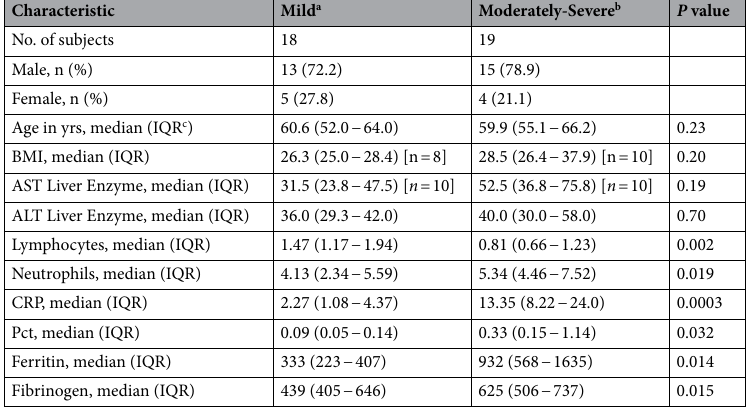
Table 1. Selected clinical and demographic parameters of the study population. CRP C reactive protein; AST aspartate aminotransferase; ALT Alanine aminotransferase. a Nasal cannula or VentMask, b CPAP, Continuous positive air pressure, c IQR, interquartile